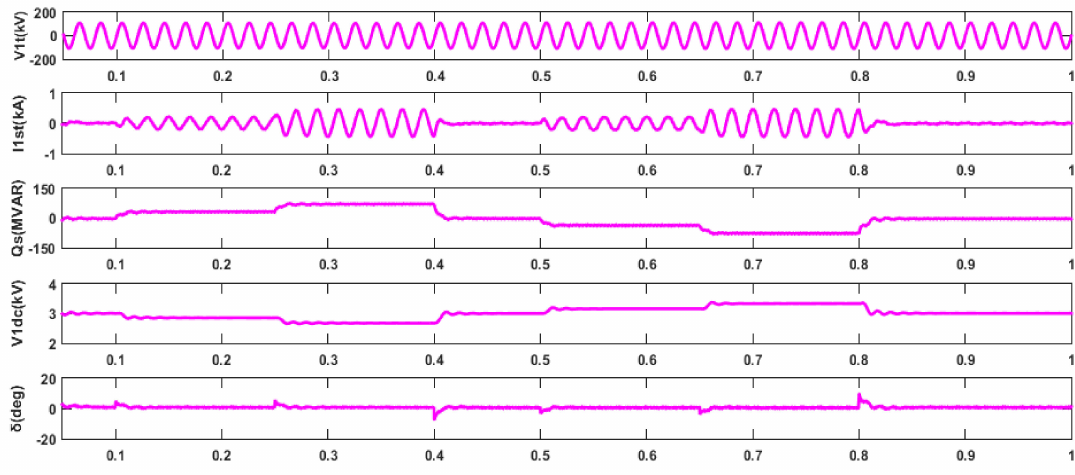
Figure 5. Cumulative load performance results of seven level VSC based STATCOM with reference reactive power changes.